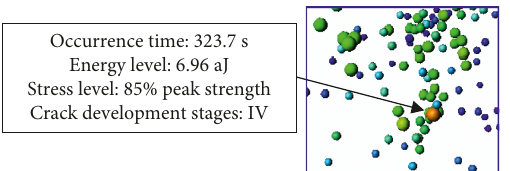
Figure 7: The spatial distribution of AE events in the area outlined by the solid lines in Figure 5(c) at 326s.